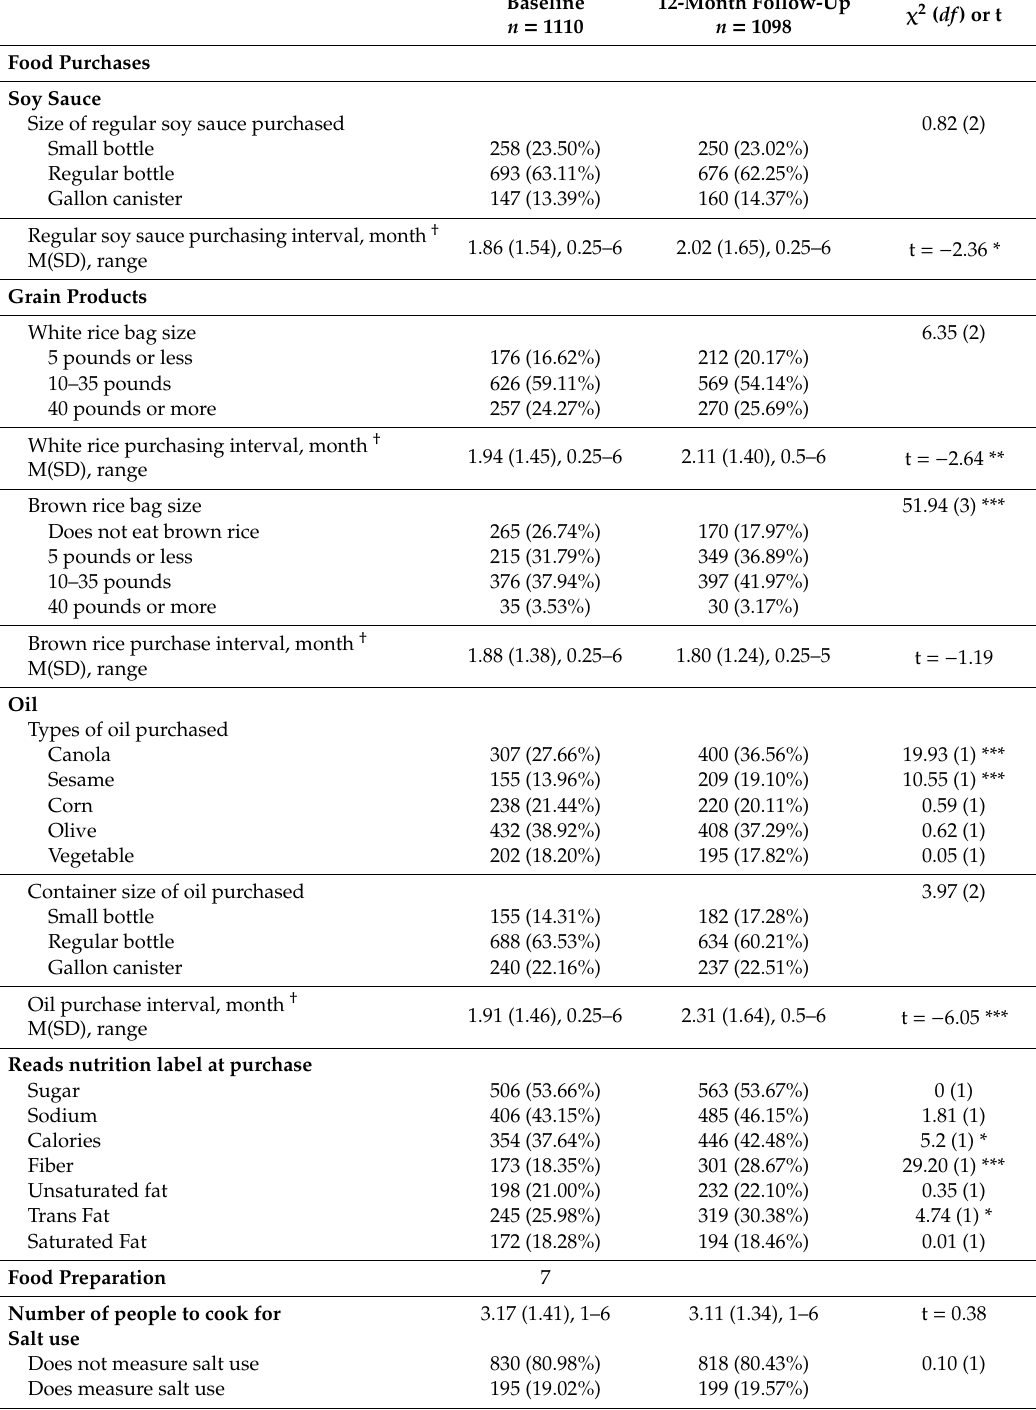
Table 2. Food Purchases, Preparation Practices, and